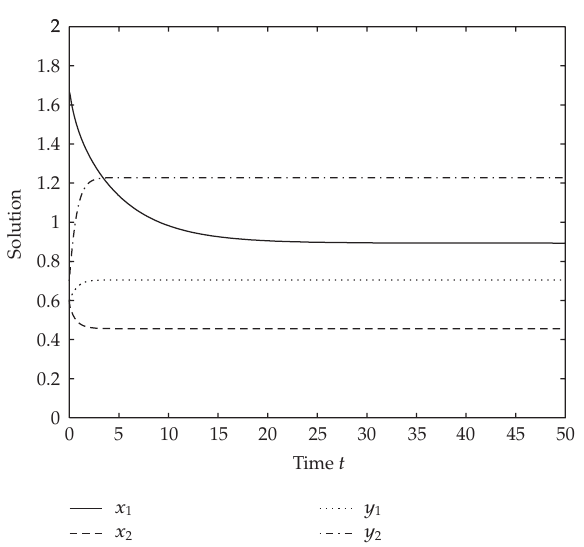
Figure 1: The temporal solution found by numerical integration of system (cid:3) 4.1 (cid:6) with τ (cid:7) 0 . 5 and (cid:3) θ (cid:6) , Φ (cid:3) θ (cid:6) , Ψ (cid:3) θ (cid:6) , Ψ (cid:3) θ (cid:6)(cid:6) (cid:7) (cid:3) 5 (cid:3) 1 − e − 0 . 5 (cid:6) , 1 , 0 . 6 , 0 . 6 (cid:6) (cid:3)Φ 1 2 1 2